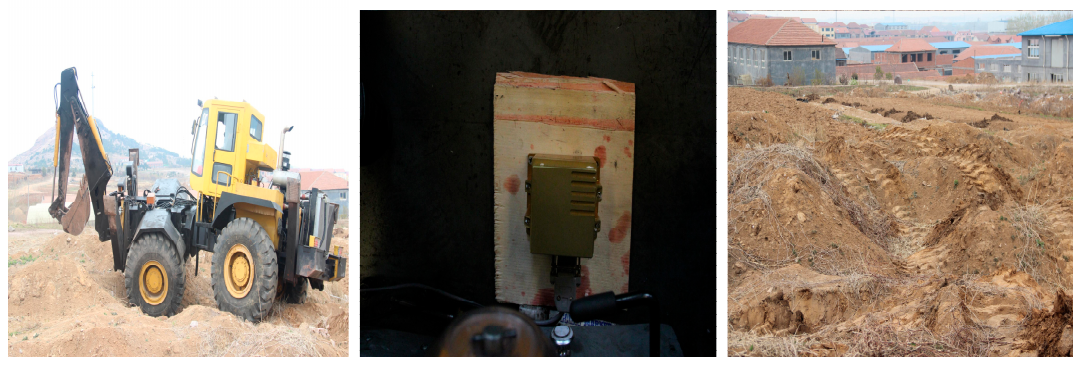
Figure 7. Rollover test devices and site.